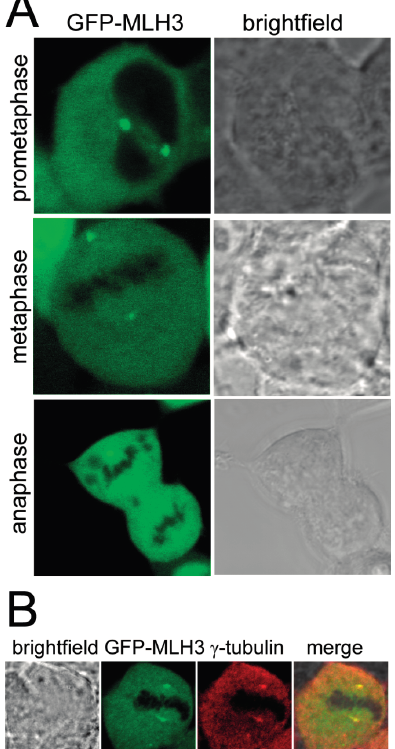
Figure 1. MLH3 accumulates at the centrosomes. ( A ) Confocal microscopy of stably transfected cells (cell line 293), in different stages of mitosis as indicated. GFP-MLH3 accumulates at two foci per cell. Exemplary pictures were chosen, where both fluorescent foci were detected in the same focal pane; and ( B ) Immunostaining of formalin-fixed and permeabilized stably transfected cells using anti- γ -tubulin antibody and a secondary antibody coupled to